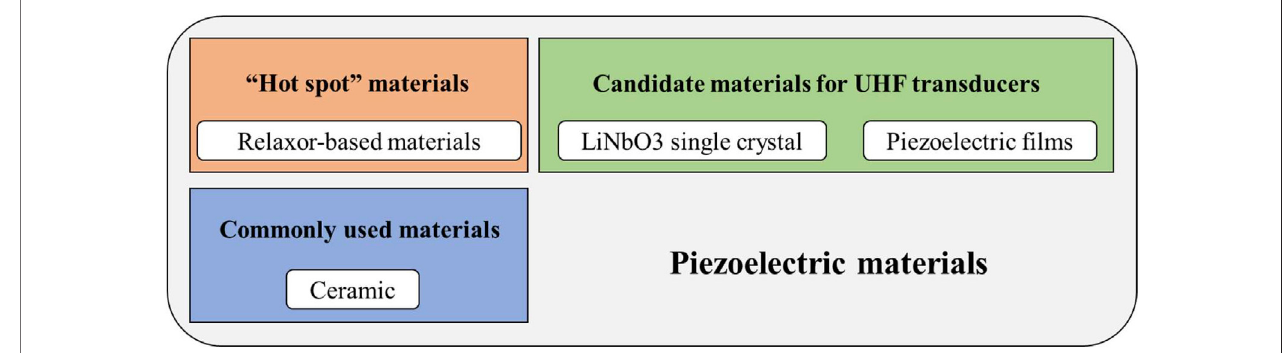
FIGURE 1 | Block diagram of Material selection.